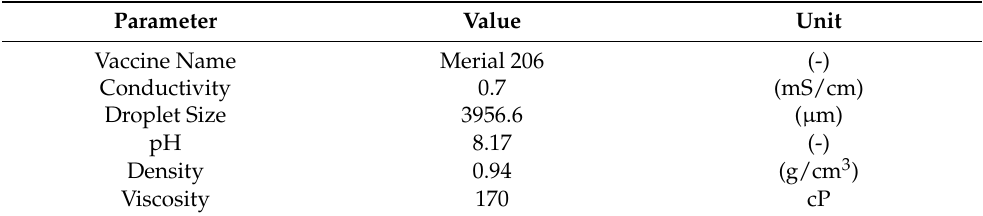
Table 2. The properties of Merial 206 vaccine for repeatability experiments with the needle-free jet